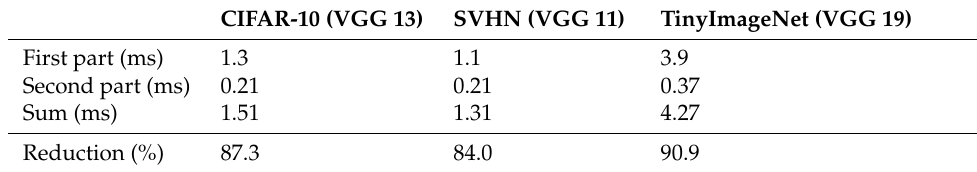
Table 7. Runtime of one batch on the models two parts in milliseconds. The fourth row is the reduction from the sum of the runtimes to the runtime of the second part, as an image has to be run through both parts, while a generated feature only needs to be run through the second part. CIFAR-10 (VGG 13) SVHN (VGG 11) TinyImageNet (VGG 19) First part (ms) 1.3 Second part (ms) 0.21 Sum (ms) Reduction